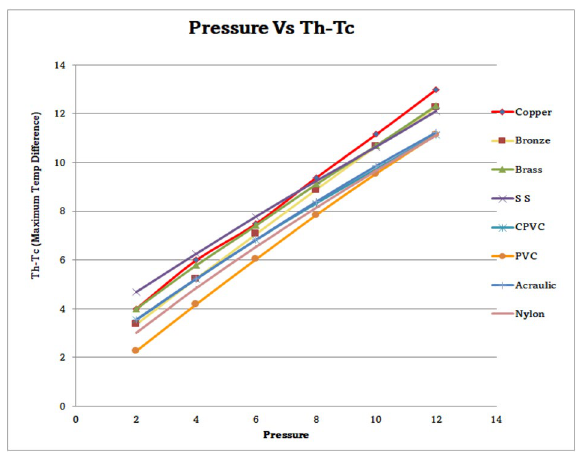
Figure 69. Pressure vs maxi temp difference.